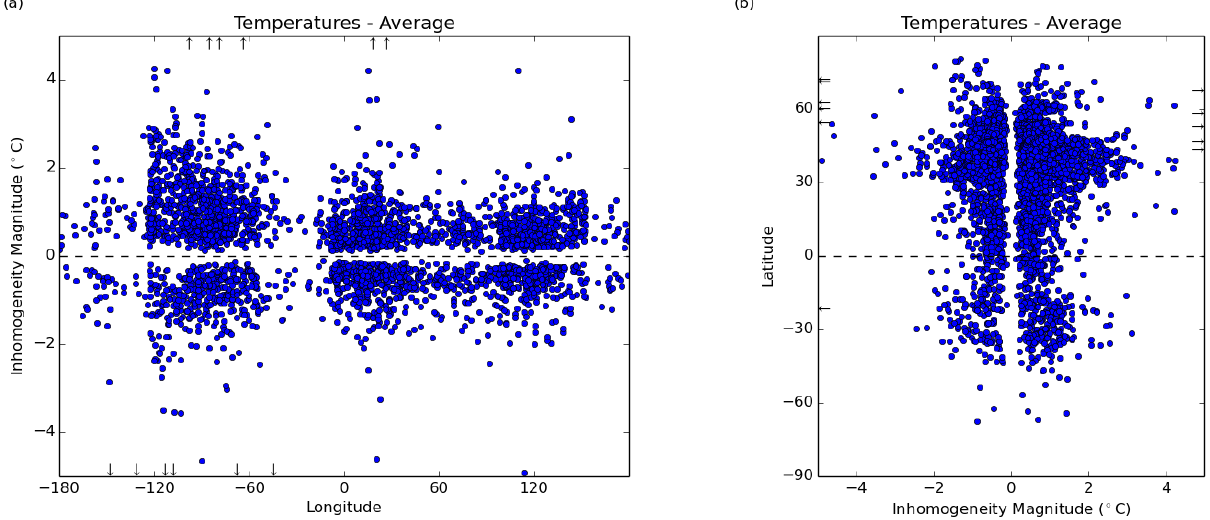
Fig. 5. The distribution of inhomogeneity magnitudes with (a) Longitude and (b) Latitude using the monthly mean temperatures. Arrows indicate values which fall outside of the plotted area.